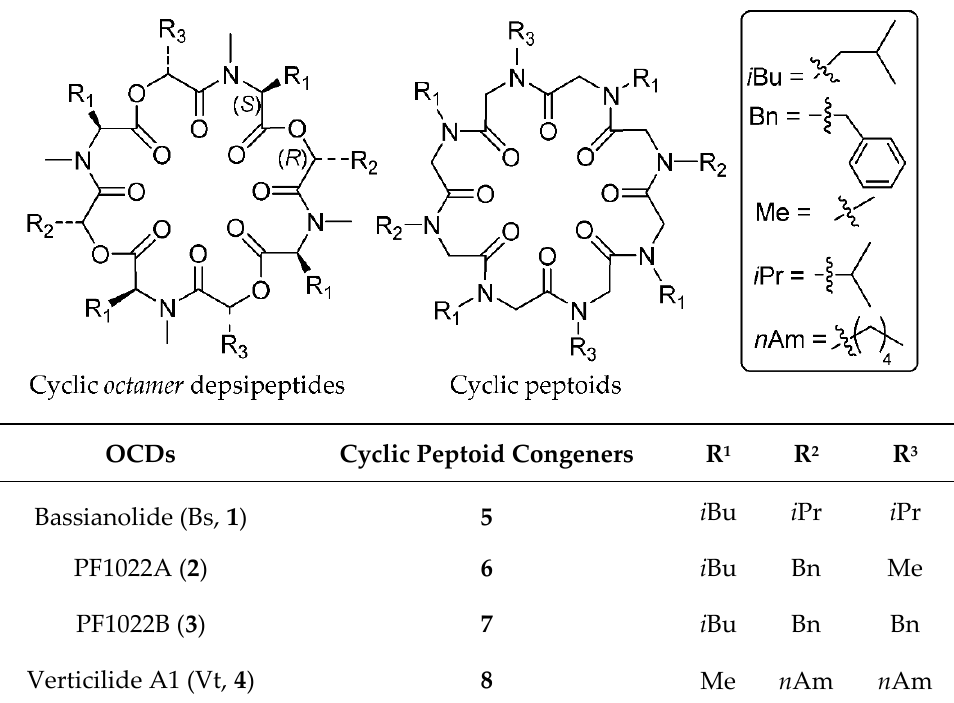
Figure 1. Natural octamer cyclic depsipeptides (OCDs) mycotoxins ( 1 – 4 ) and cyclic peptoid congeners ( 5 – 8 ) synthesized in the present paper.